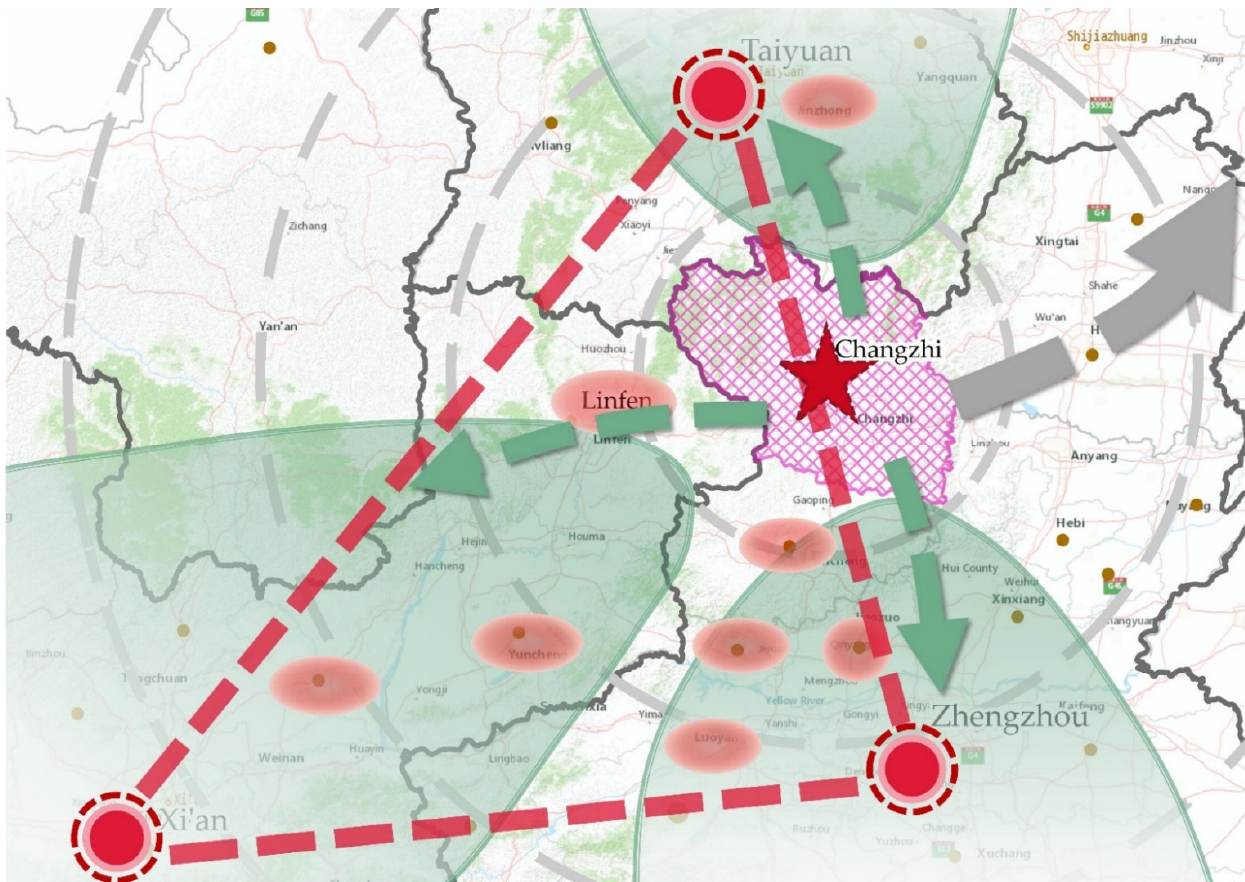
Figure 8. Strategic planning for Changzhi visionary space development. Table 2. Cooperation directions of